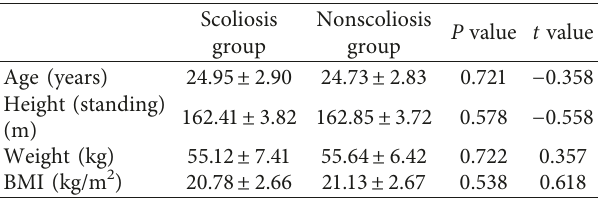
Table 1: Descriptive analysis of the characteristic of subjects in the two groups in this study (SD, standard